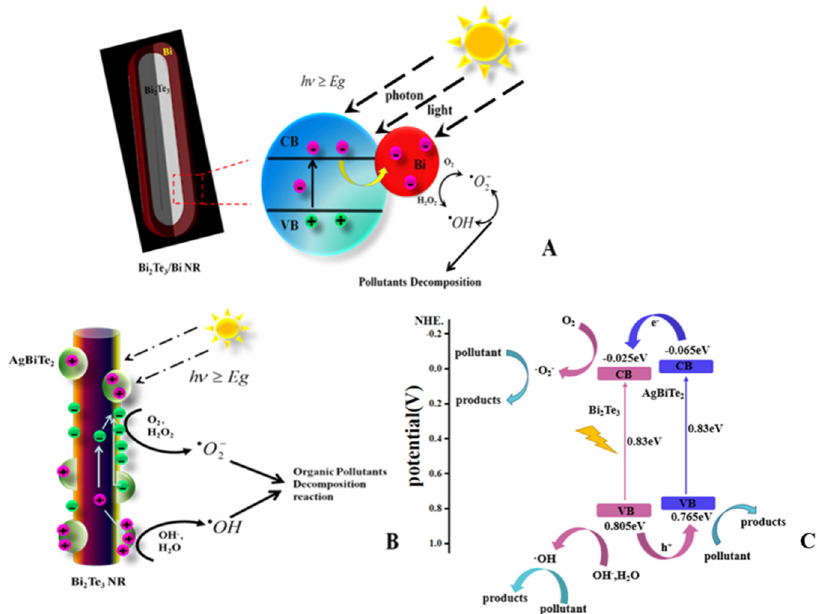
Figure 6. Schematic illustration of the mechanism for the photocatalysis by ( A ) Bi 2 Te 3 /Bi core − shell NRs. ( B ) Bi 2 Te 3 /AgBiTe 2 heterostructure NRs materials under vis-light irradiation. ( C ) Schematic illustration of the mechanism for the photocatalysis by the Bi 2 Te 3 /AgBiTe 2 heterostructure under visible irradiation.